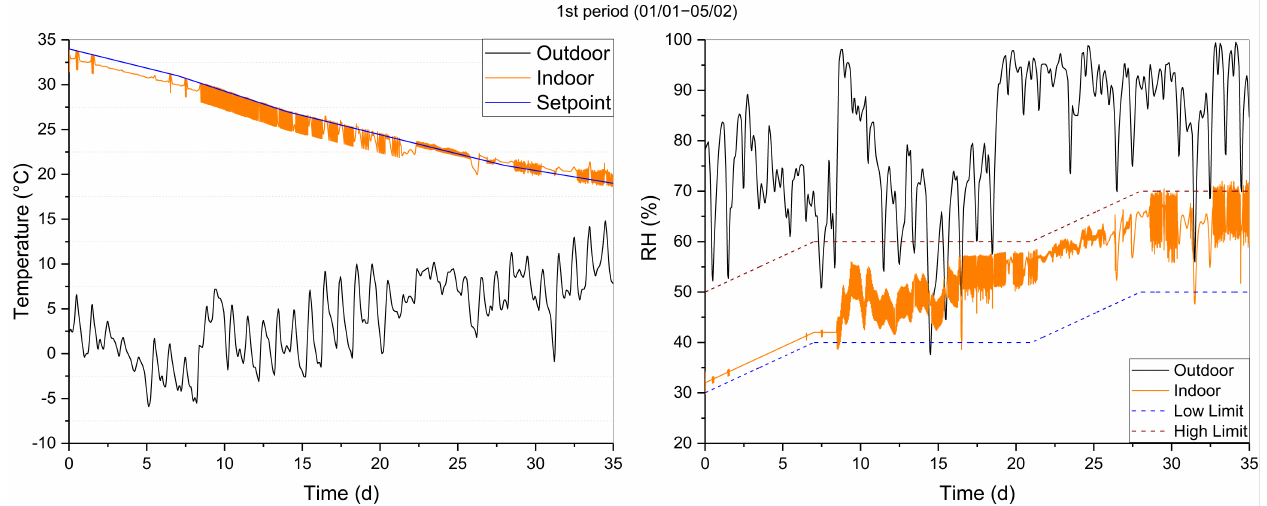
Figure 5. Temperatures and relative humidity variation during the 1st production period